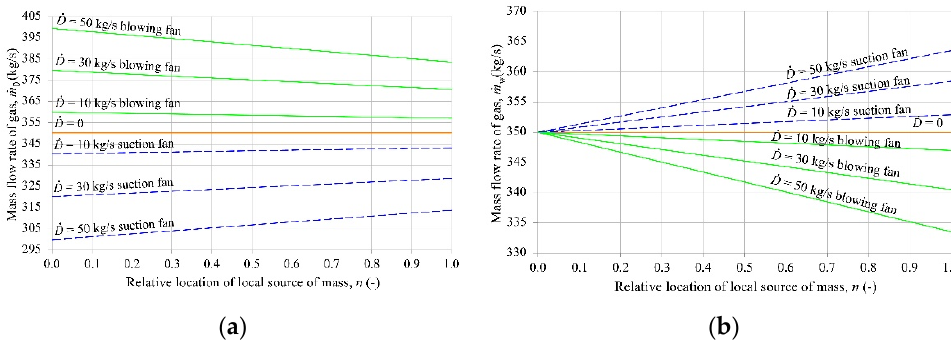
Figure 2. Results of numerical calculations for ( a ) Case 1a, ( b ) Case 1b. The orange color is used to mark the straight line corresponding to the reference value for D = 0, the green straight lines represent the fan working in the blowing mode, and the dotted lines apply to the fan working in the suction mode.